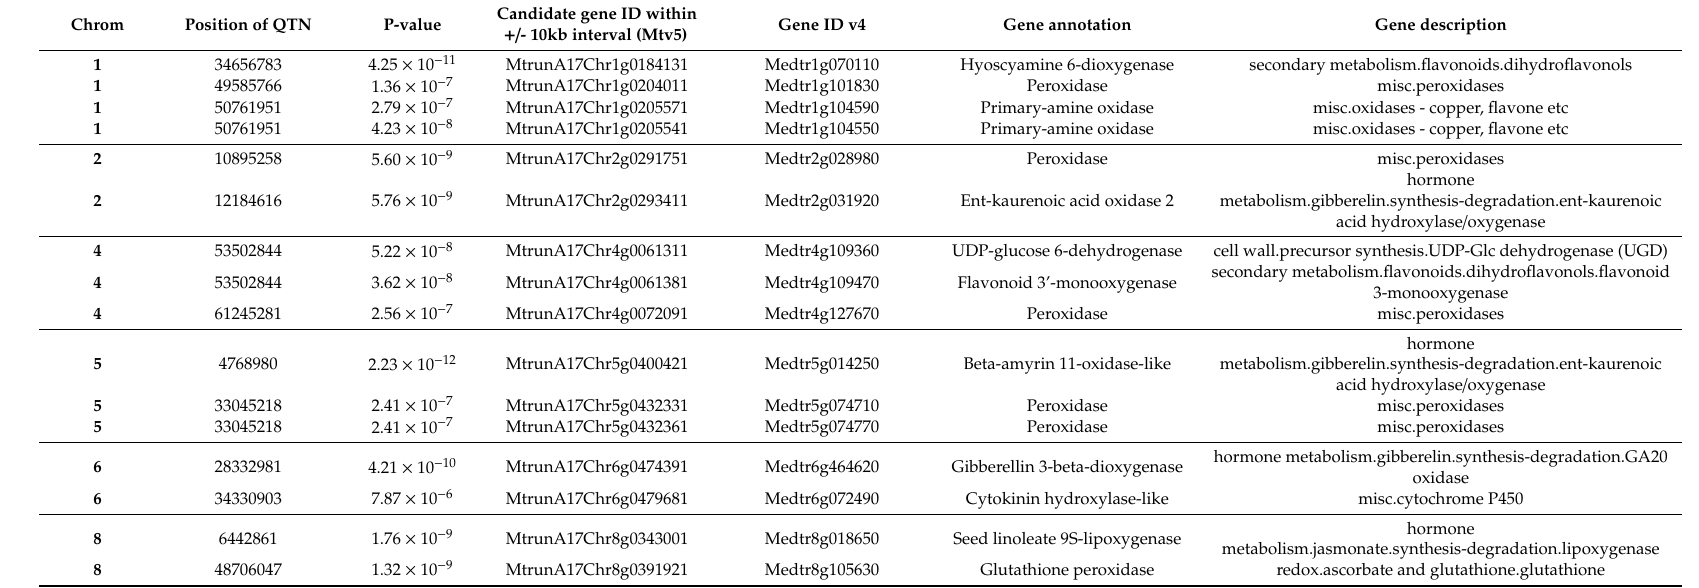
Table 1. List of Quantitative Trait Nucleotides (QTNs) identified by genome-wide association (GWA) analysis of each dormancy trait and belonging to one of three biological function over-represented in our complete list of candidate QTNs. Corresponding chromosome locations and p-values of QTNs are indicated as well as the closest gene ID within +/ - 10 kb genomic interval and its corresponding annotations (Mtv5 annotations, Mtv4 annotations, gene ontology, and gene description). For complete list and description of all identified QTNs see Supplementary data Tables S6 and